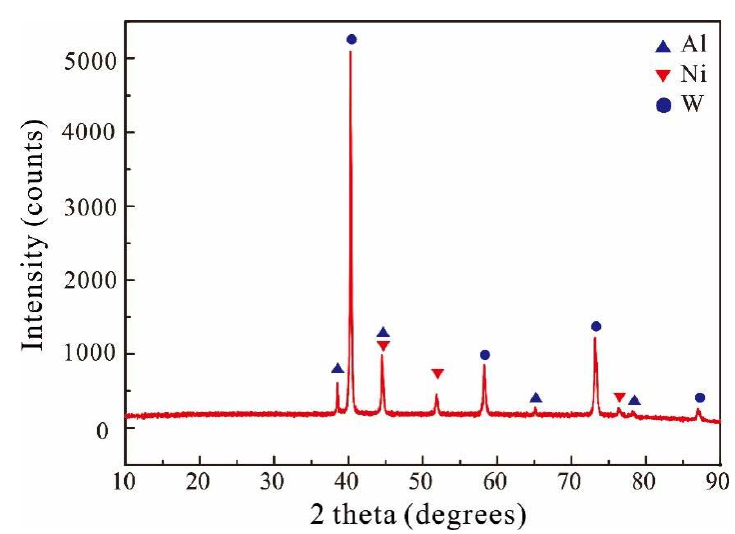
Figure 2. XRD patterns of the hot ‐ pressed (48Al–52Ni) 40 W 60 composites.